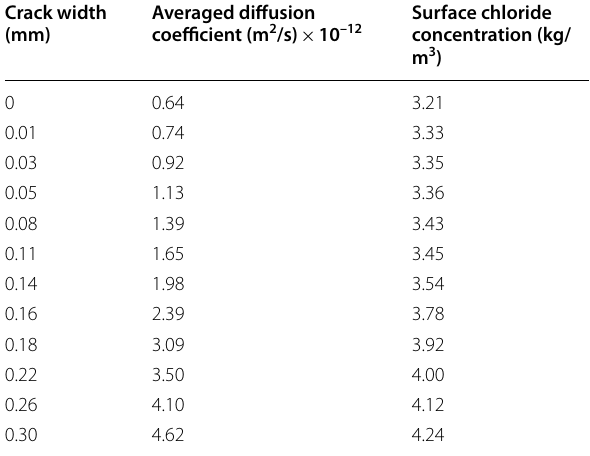
Table 3 Experimental results for apparent diffusion coefficient and surface chloride